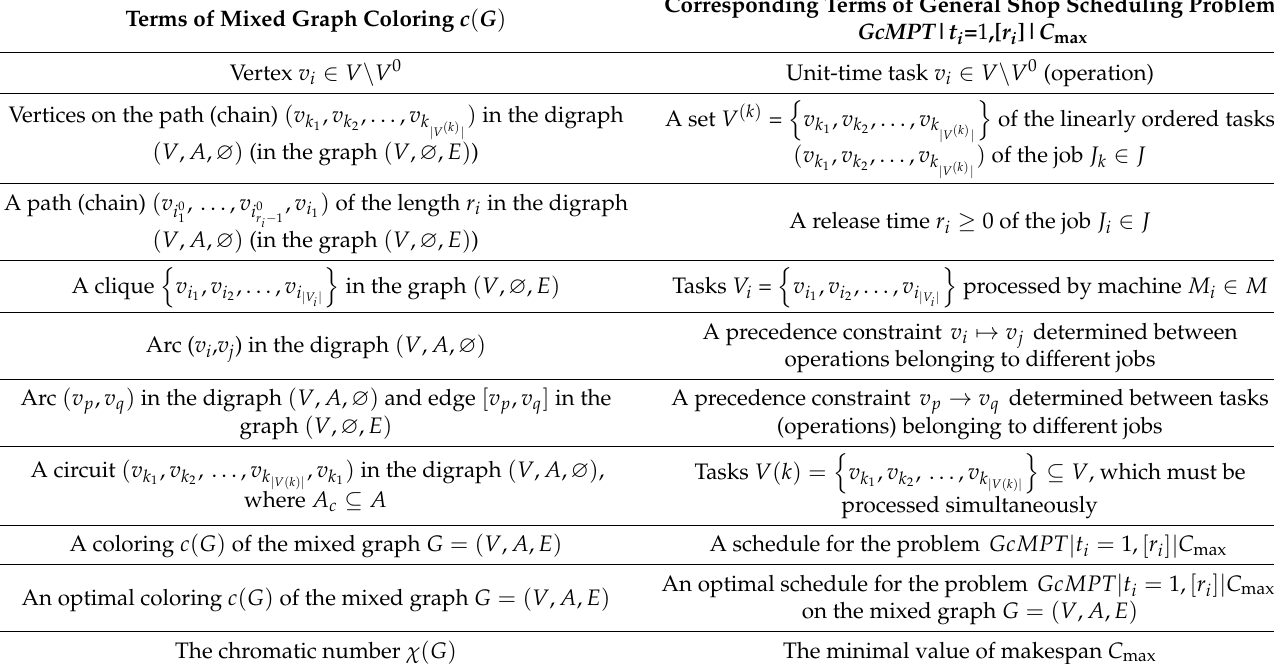
Table 1. The correspondence of terms used in mixed graph coloring c ( G ) and those used in the general shop scheduling problem GcMPT | t i = 1, [ r i ] | C max on the mixed graph G = ( V , A , E ) . Corresponding Terms of General Shop Scheduling Problem Terms of Mixed Graph Coloring c ( G ) GcMPT | t i = 1 ,[ r i ]| C max Vertex v i ∈ V \ V 0 Unit-time task v i ∈ V \ V 0 (operation) ) in the , v k , . . . , v k Vertices on the path (chain) ( v k 2 1 | V ( k ) |